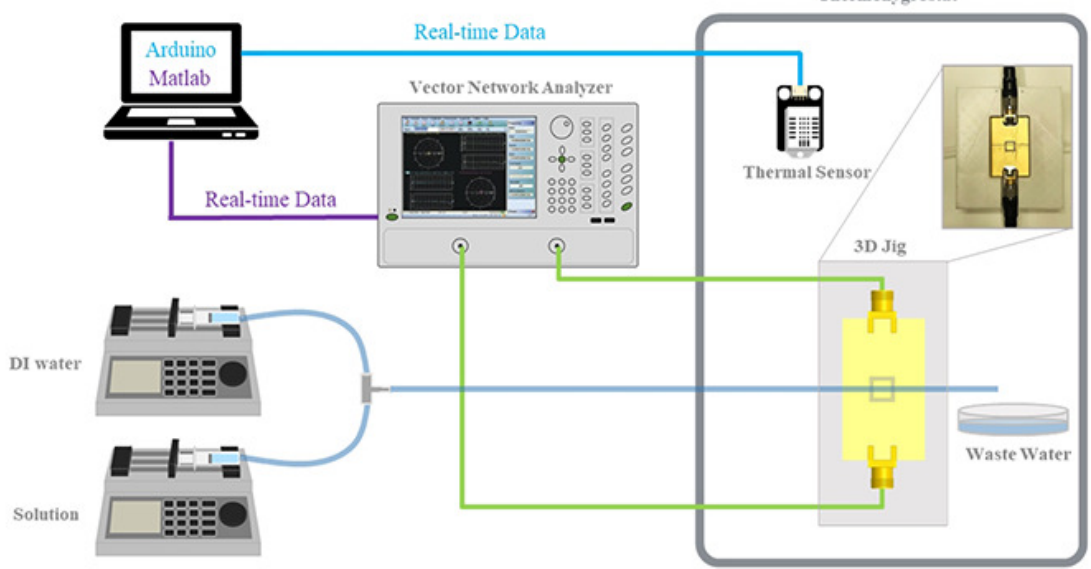
Figure 5. Measurement setup for temperature control and testing the performance of the proposed